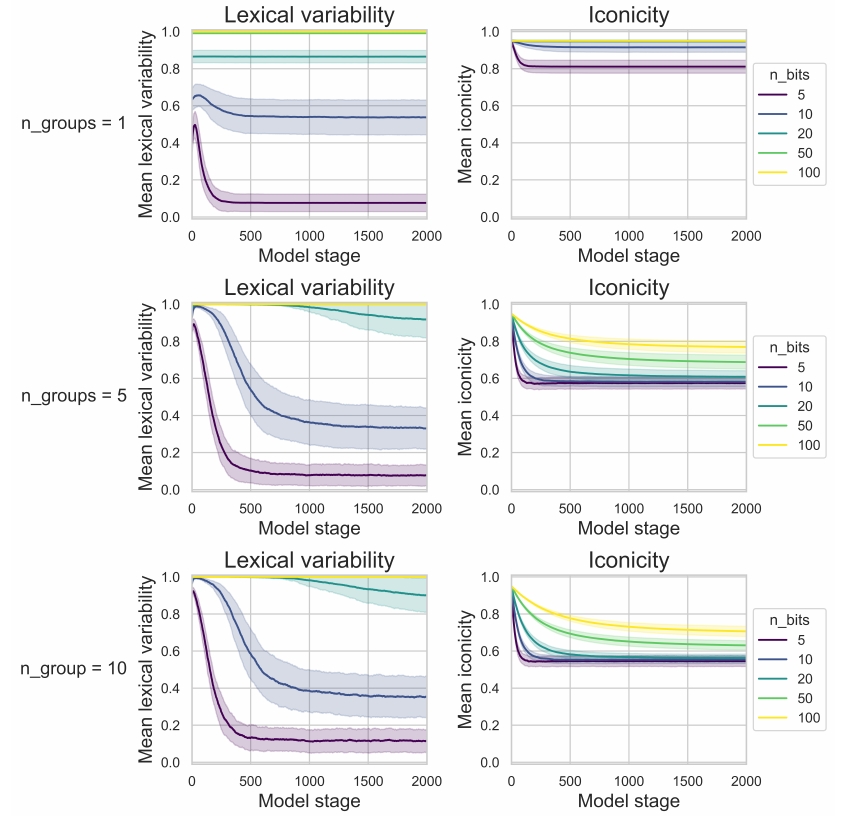
Figure A3. The mean lexical variability over the 2000 model stages for runs with a different number of bits ( n_bits ): 5, 10, 20, 50, 100 and for different numbers of groups that agents can be assigned to ( n_groups ): 1, 5, 10. The dark line represents the mean and the shaded area represents the standard deviation of the 100 repetitions. The lexical variability value is higher when there are more bits. The number of bits also affects the lexical variability value at stage 0. The more bits, the higher the iconicity